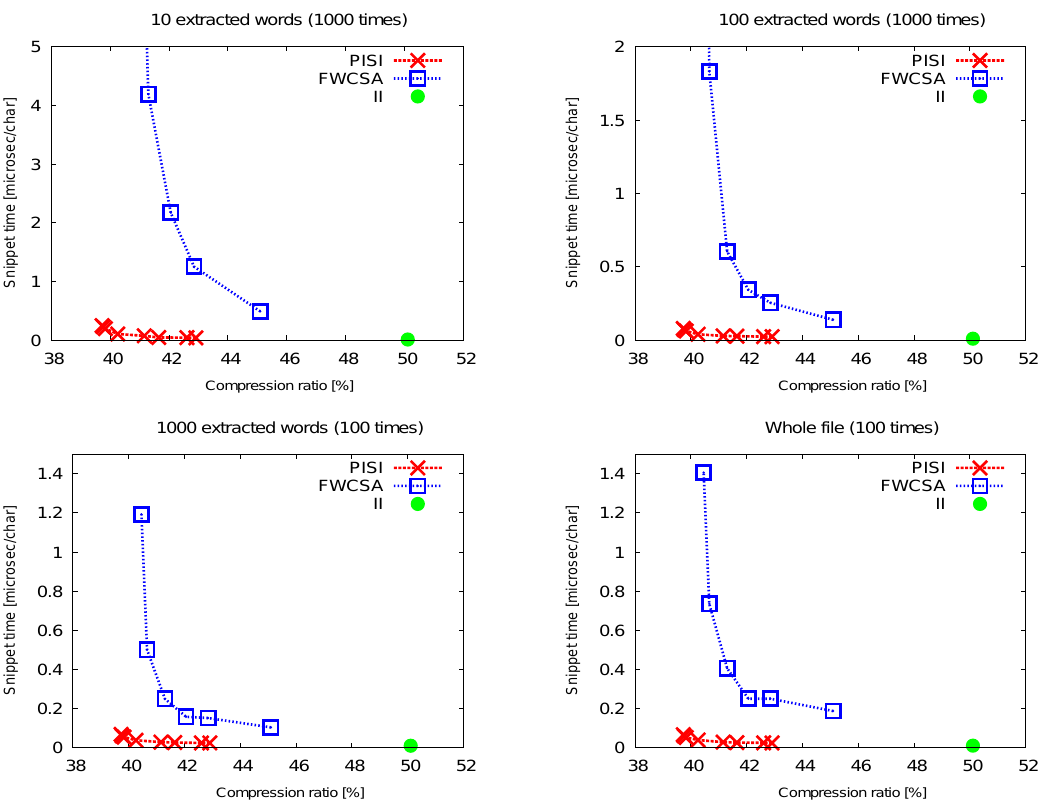
Figure 5. Compression ratio/Snippet time trade-off. The time is stated in microseconds per